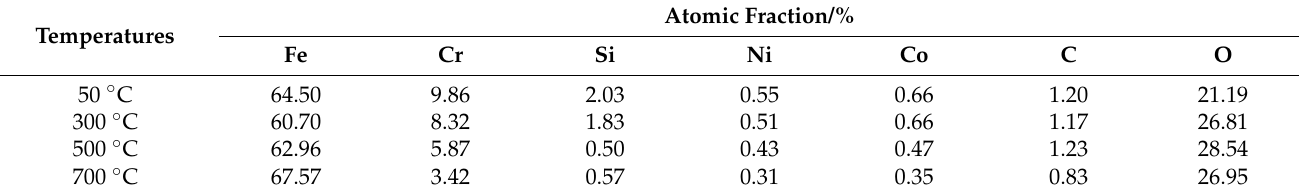
Table 5. EDS analysis outcomes of worn surfaces of FeCrSiNiCoC coatings at various